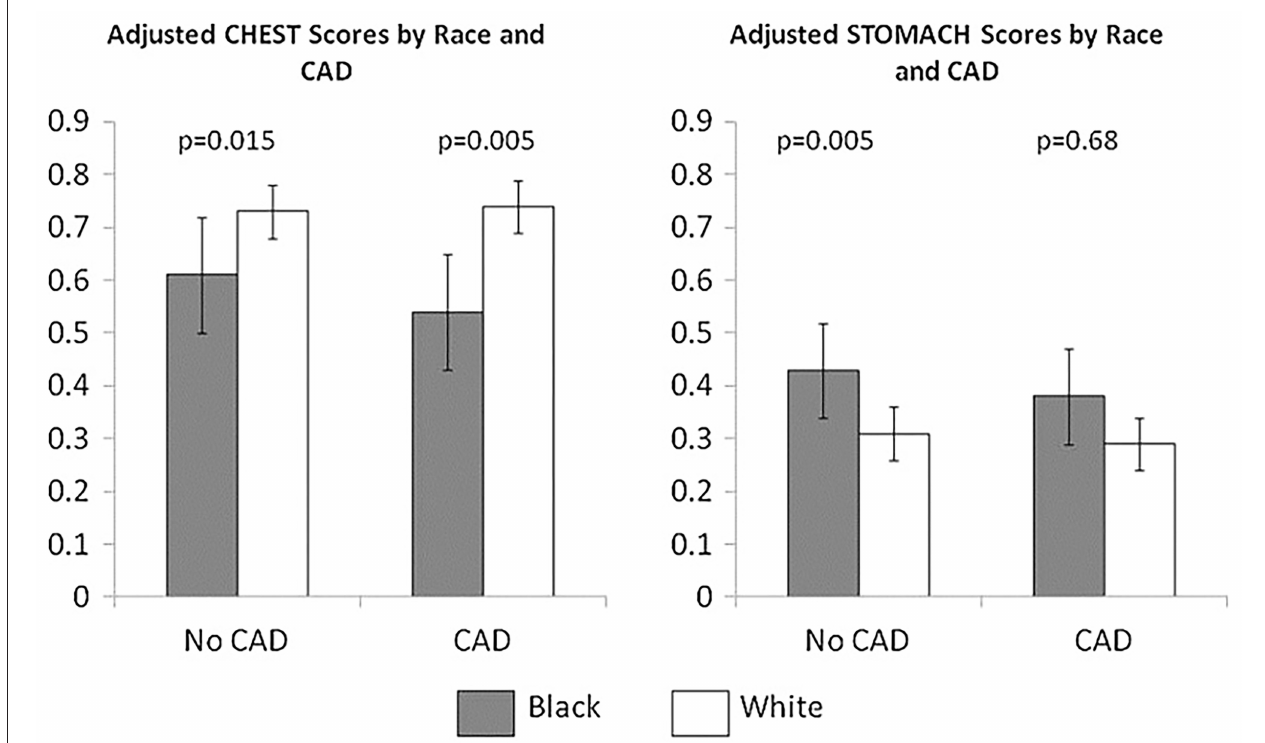
FIGURE 4 | Stomach and chest angina symptoms in black women vs. white women with suspected CAD. Symptom clusters were derived from a cohort of 466 women (69 black,397 white) undergoing coronary angiography for suspected CAD. Chest symptoms included chest discomfort, pressure, tightness, fatigue, and shortness of breath. Stomach symptoms included indigestion, esophagus, throat, and abdomen symptoms. Mean adjusted chest and stomach scores stratified by race (black vs. white) and presence vs. absence of obstructive CAD. Reprinted with permission (